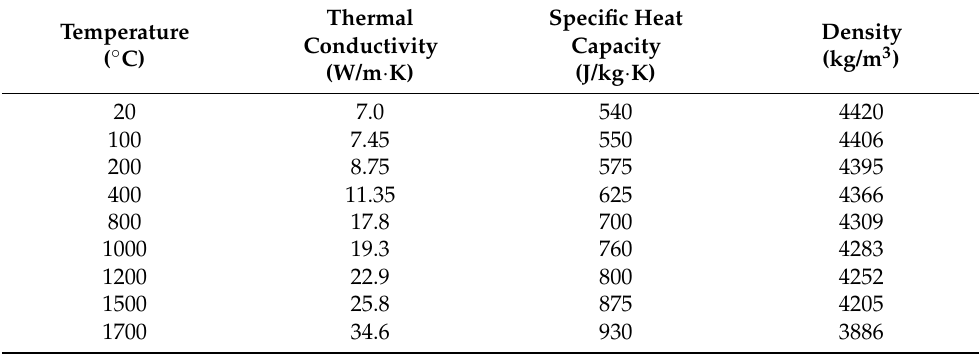
Table 3. Thermophysical properties of Ti-6Al-4V